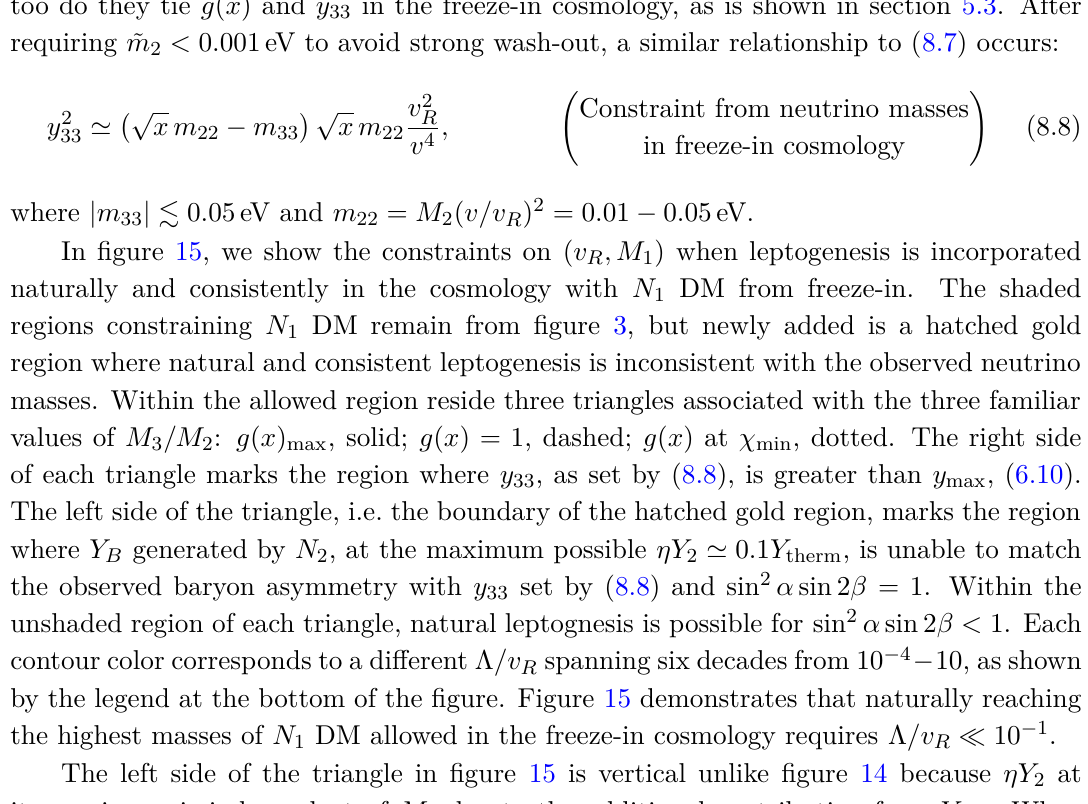
on figure 14. For larger values of Λ /v parameter space for v constraints from ∆ y